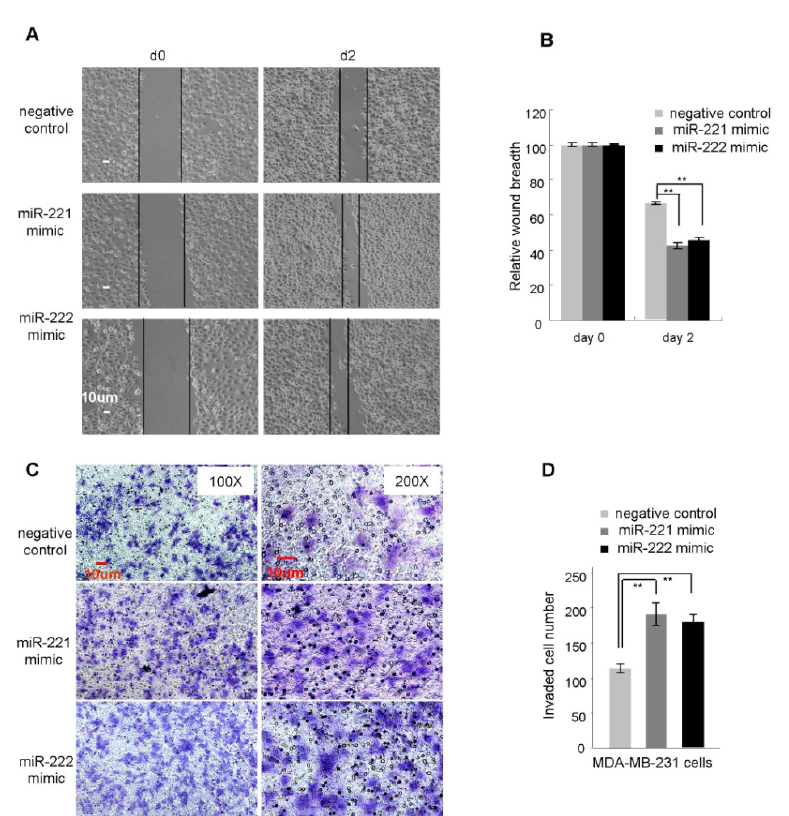
Figure 2. miR-221 and miR-222 promote cell migration and invasion in MDA-MB-231 cells. ( A ) Wound healing assays were performed on MDA-MB-231 cells (0.1% FBS) treated with miR-221 mimic, miR-222 mimic or negative control. The wound breadths were measured at the indicated time points. ( B ) Quantitative analysis of the cellular migration assayed in A. ( C ) Transwell invasion assay was performed on MDA-MB-231 cells treated with miR-221 mimic, miR-222 mimic or negative control. (D) Quantitative analysis of the invaded cells assayed in C. Data are mean ± SEM ( n = 3). ** p <